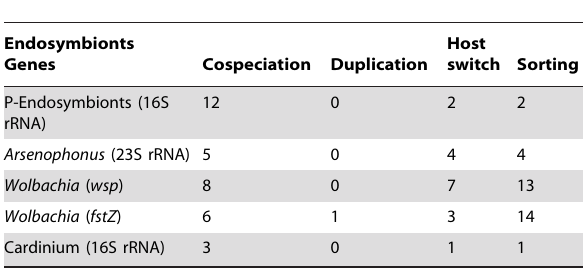
Table 2. Summary of co-phylogenetic comparisons of host species and their endosymbionts ML